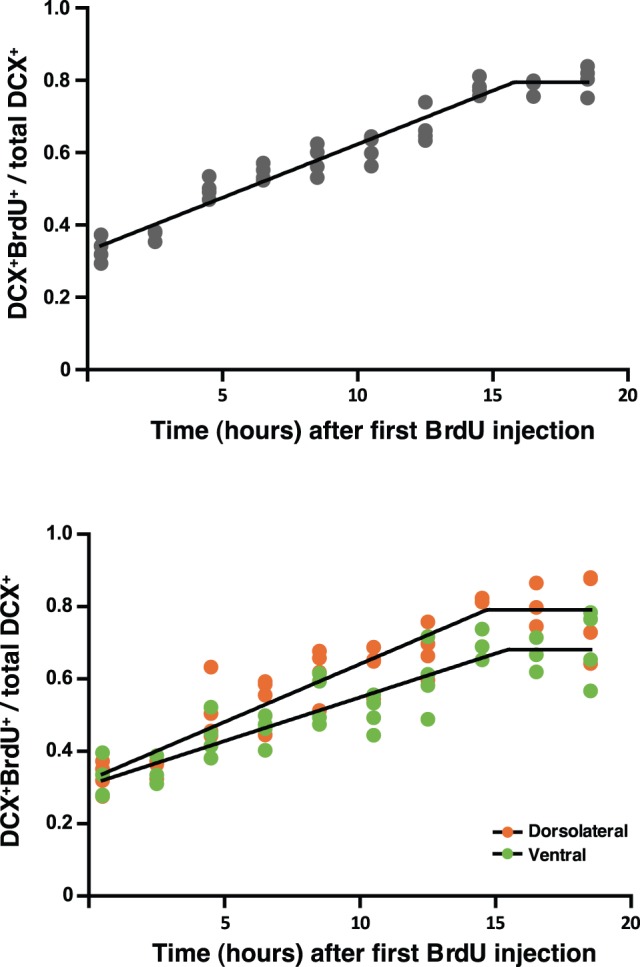
Estimation of the cell cycle length of the DCX positive cell population reveals differences between dorsolateral and ventral subependymal zone at intermediate levels.A cumulative BrdU labeling protocol was performed to determine cell cycle length for DCX positive cells. The time points for BrdU injections are plotted against the percentage of the total DCX population (DCX positive cells) that is proliferating (double DCX/BrdU positive cells) at each time point. When this percentage is constant (the graphic reaches a plateau) it is named Growth Fraction (GF). The parameters to calculate cell cycle length (Tc) are obtained from the following parameters: GF and slope of the first linear fragment. This procedure was performed for DCX positive cells from the entire SEZ (A) or from dorsolateral and ventral SEZ at intermediate levels separately (B).